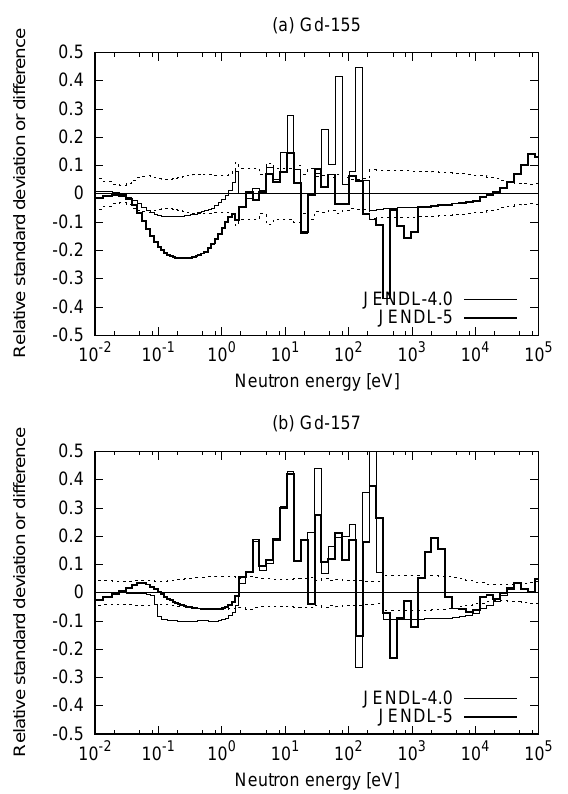
Figure 12. Relative di ff erence in group-wise (n, γ ) cross section of Gd-155 and -157 from the ENDF / B-VIII.0